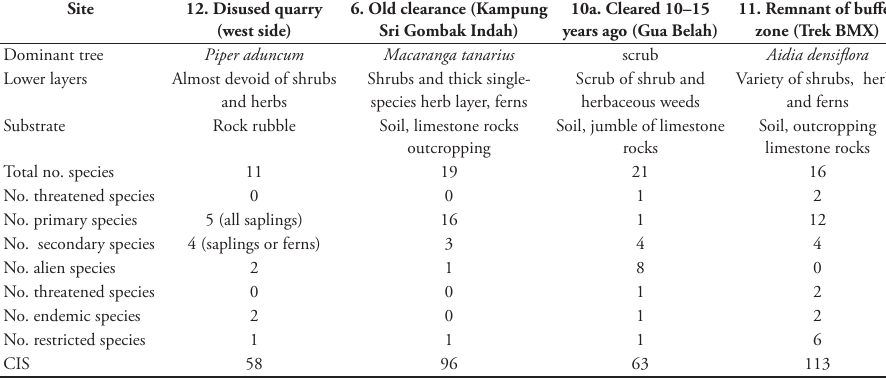
Table 11. Recovery of the vegetation on degraded sites.